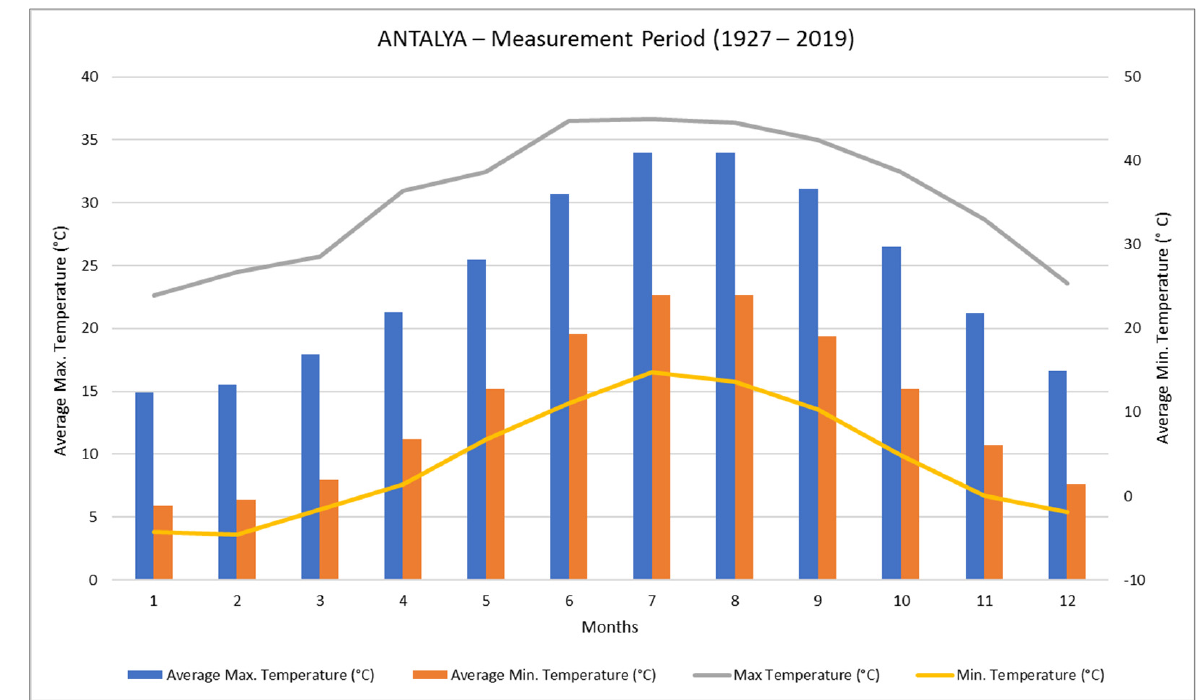
Figure 3. Annual temperature values of the Antalya (TSS 2021).